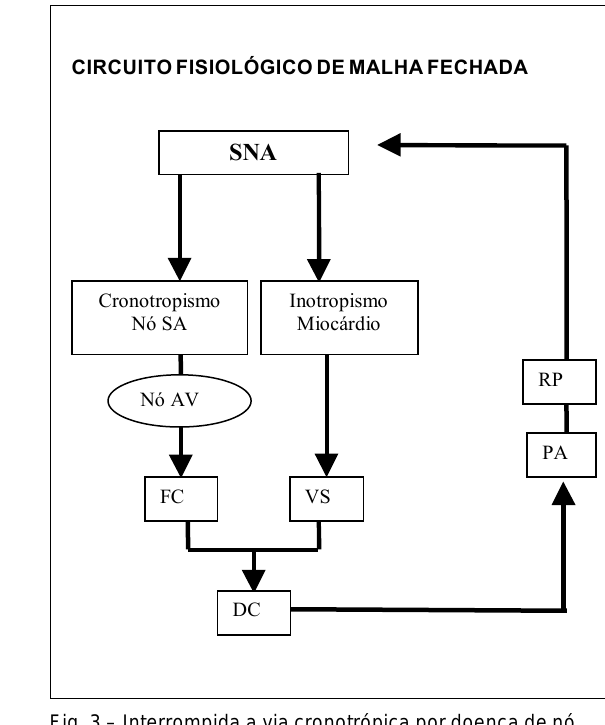
Fig. 3 – Interrompida a via cronotrópica por doença de nó sinusal ou por Bloqueio AV, o restabelecimento da variação da FC é feito artificialmente com o MP, via inotropismo